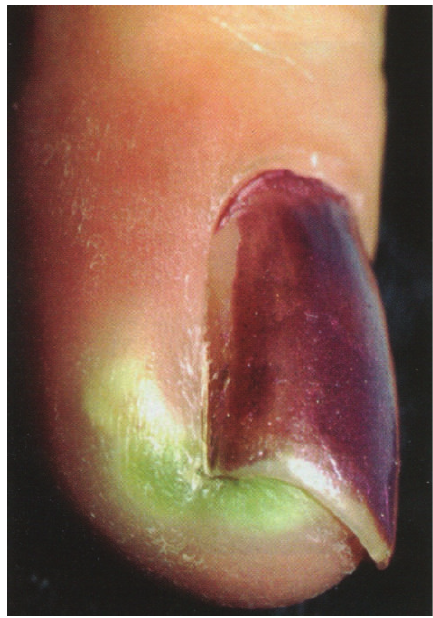
Figure 6: Cellulite of the fingertip [9, page 1000].